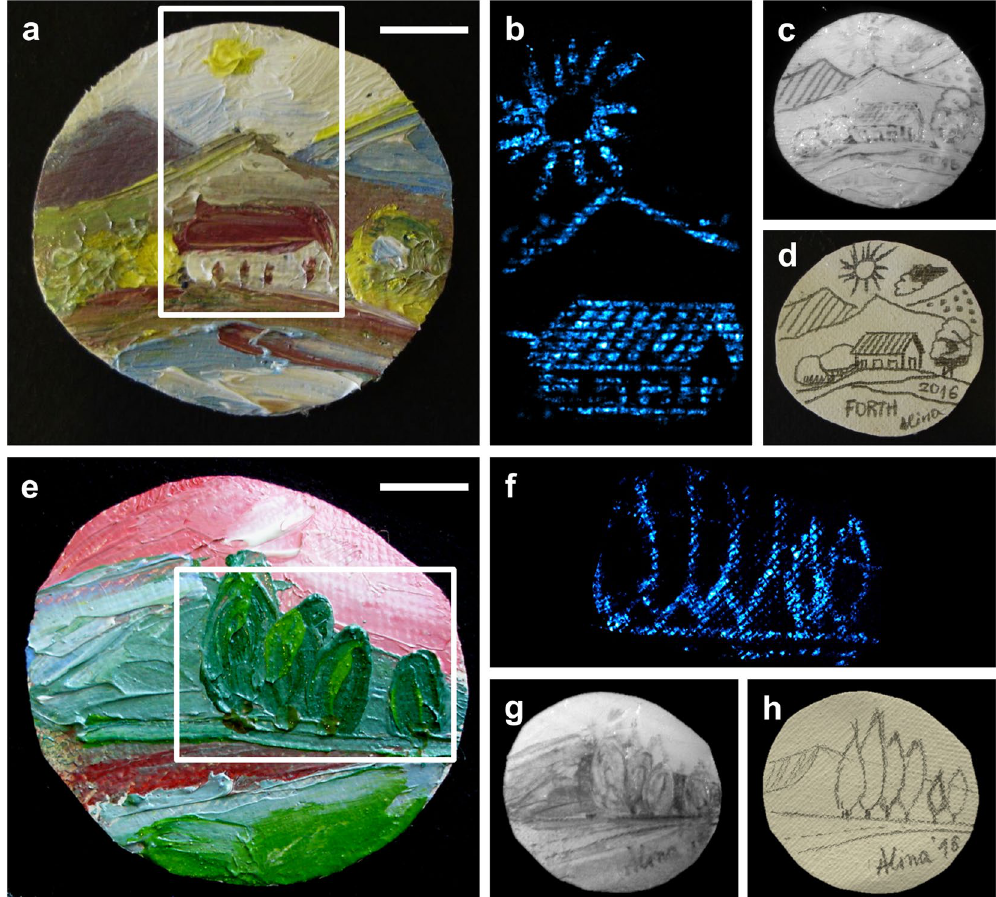
Figure 4. Photoacoustic detection of underdrawings in miniature paintings. ( a ) Brightfield view of miniature painting (rural landscape). ( b ) Photoacoustic image of the painting’s underlying sketch over a central region of 2.2 × 3.8 cm as indicated by the white box in ( a ). ( c ) NIR image of the underdrawing at 1200 nm. ( d ) Brightfield view of the original pencil sketch prior to overpainting. ( e ) Brightfield view of miniature painting (forest landscape). ( f ) Photoacoustic image of the underdrawing for the indicated region in ( e ) with lateral dimensions equal to 3.4 × 2.4 cm 2 . ( g ) NIR image of the painting at 1200 nm. ( h ) Original pencil sketch before overpainting. Both scalebars: 1